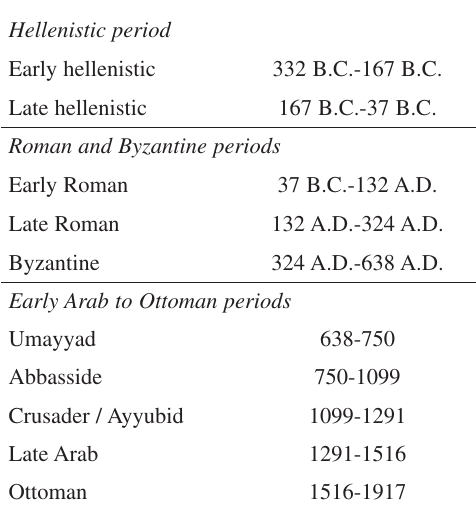
Table II. Dominant regimes in the Holy